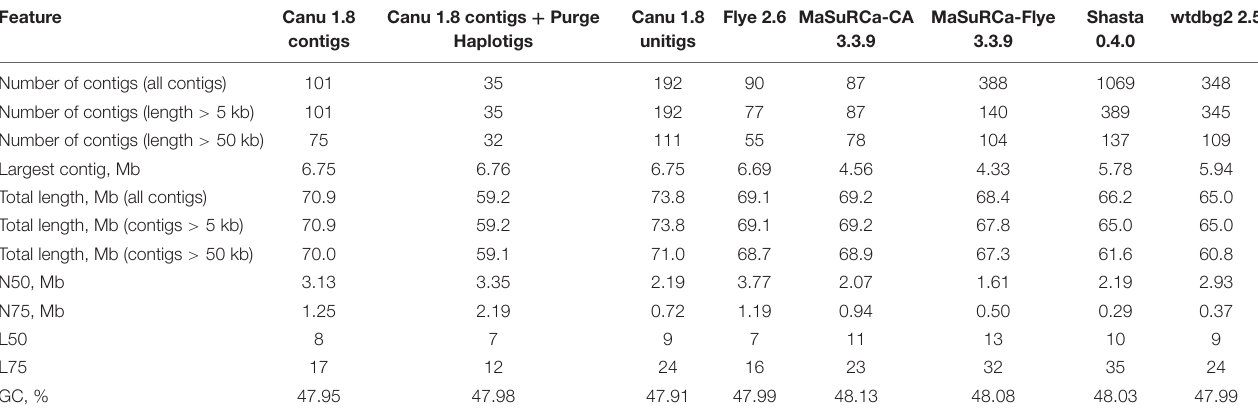
TABLE 1 | The QUAST statistics across 5 assemblers.